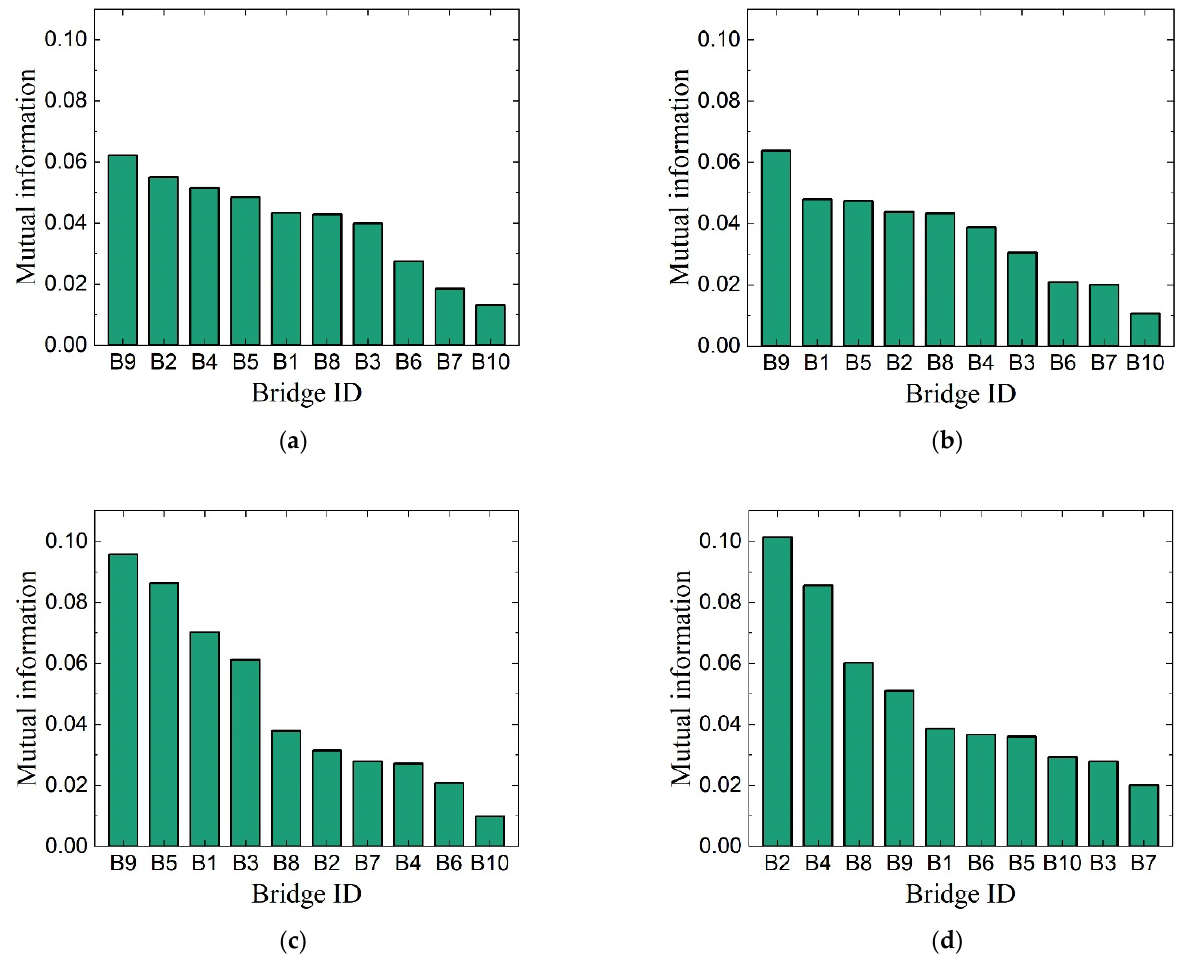
Figure 4. MI-based importance ranking results. ( a ) Case 1; ( b ) Case 2; ( c ) Case 3; ( d ) Case 4.